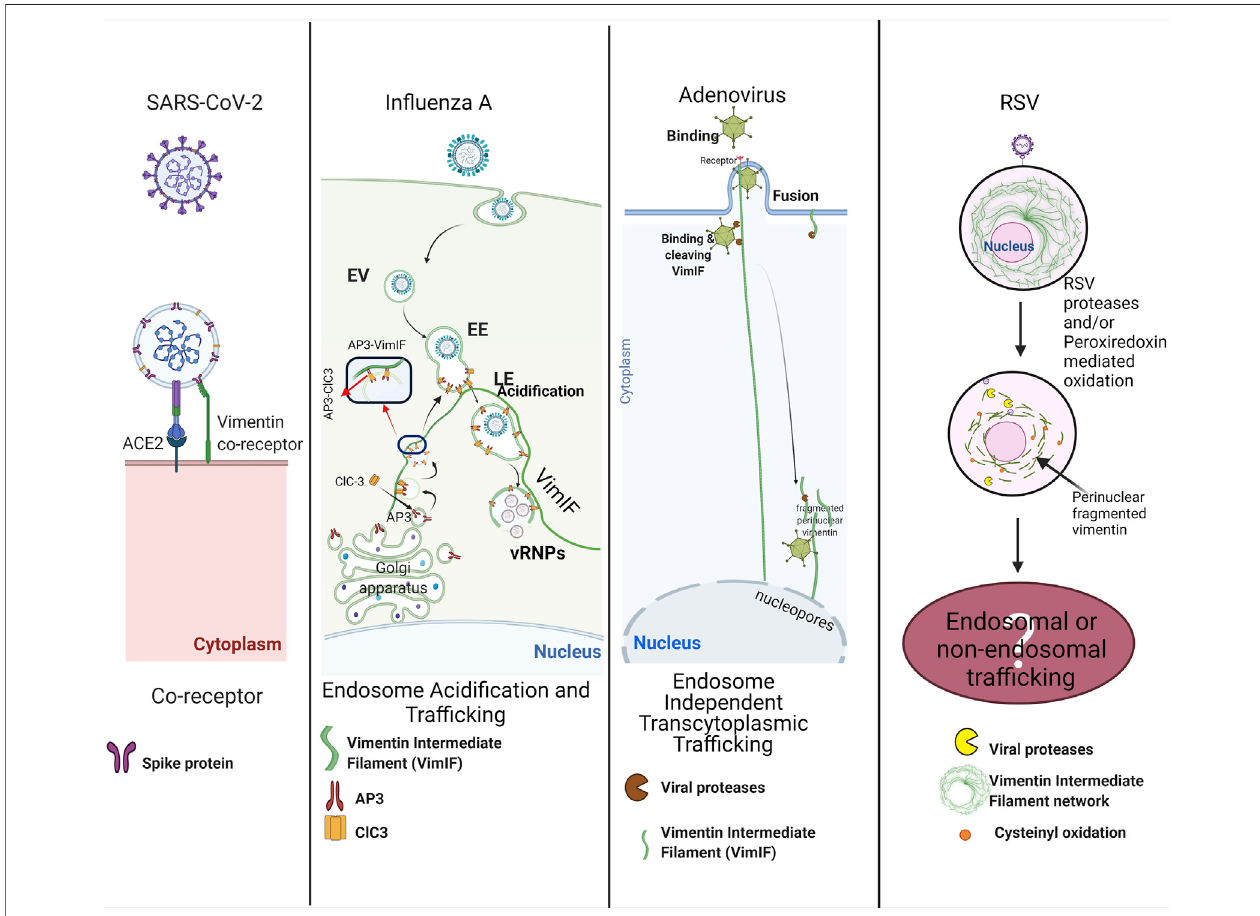
FIGURE 2 | Multiple roles of vimentin in viral respiratory infections: SARS-CoV2 exploits surface vimentin co-receptor for the entry in the host cell. In fl uenza A virus utilizes vimentin regulated traf fi cking of late endosomes for the release of vRNPs near the host nucleus. Adenoviruses bind to vimentin intermediate fi laments (VimIFs) after host cell invasion, and the viral proteases cleave vimentin intermediate fi laments to shuttle viruses in the vicinity of the host nucleus, also called endosome independenttranscytoplasmictraf fi cking.RSVinfectioncausescleavingofVimIFsandaccumulationofVimIFintheperi-nuclearregion.AlterationsinVimIFsmaybe associated with endosomal traf fi cking or non-endosomal traf fi cking for the shuttling virus next to the nucleus for its replication. The fi gure was created with BioRender.com.